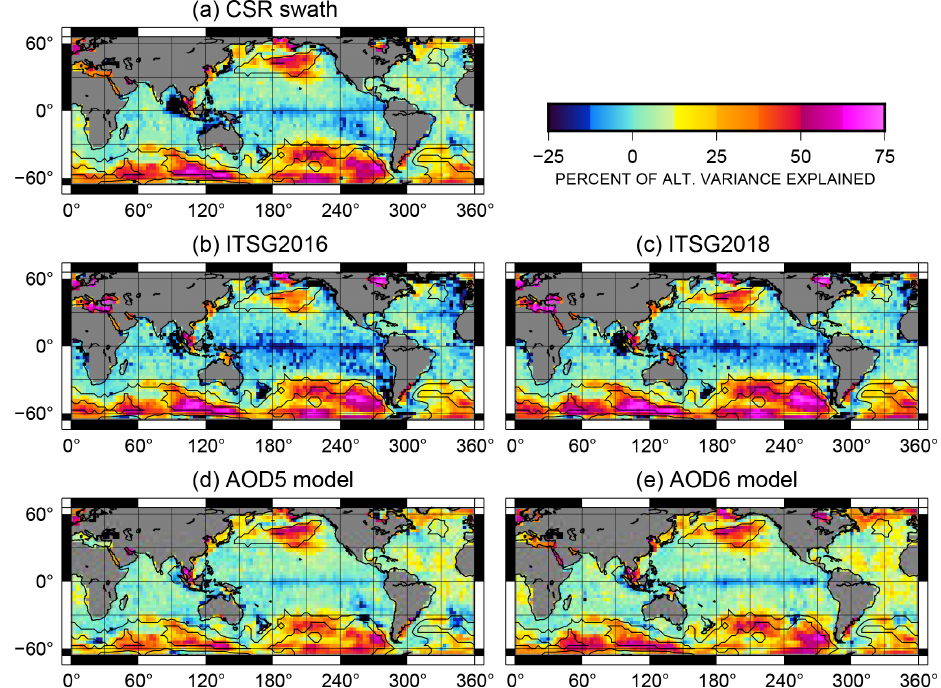
Figure 3. Percent of altimetric variance explained by five different series: (a) CSR swath GRACE data, (b) ITSG2016 GRACE data, (c) ITSG2018 GRACE data, (d) AOD5 ocean de-aliasing model, and (e) AOD6 ocean de-aliasing model.